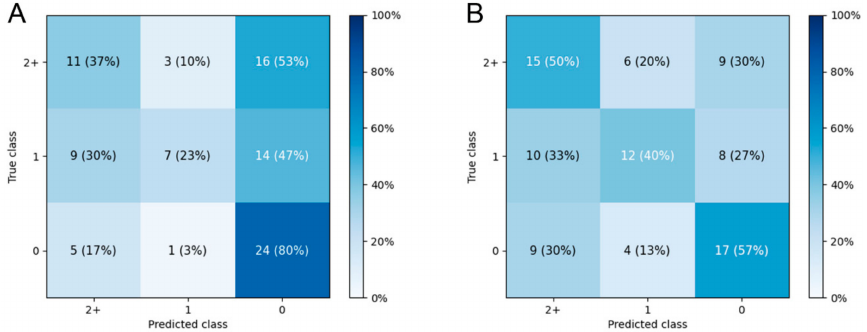
Figure 4. Confusion matrices of the best-performing folds on ( A ) DenseNet-201 and ( B ) EfficientNet-B7 for the FS grade prediction.